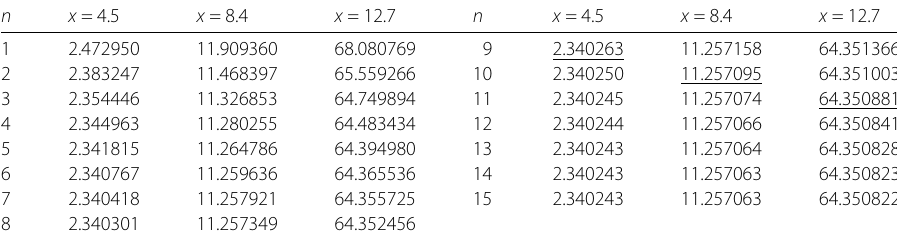
Table 1 Some numerical results for calculation of Γ q ( x ) with q = 1 and n = 1,2, ... ,15 of Algorithm 2